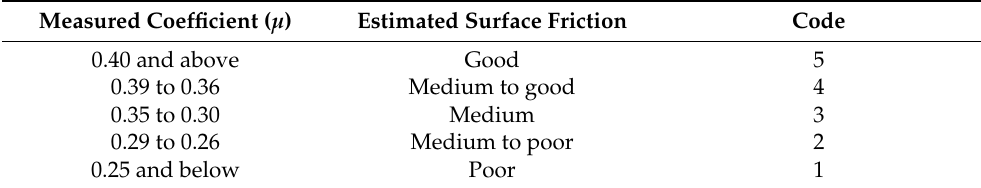
Table 1. Summary of the friction coefficient values and the assessment of braking efficiency for snow-covered and ice-covered airfield pavements.